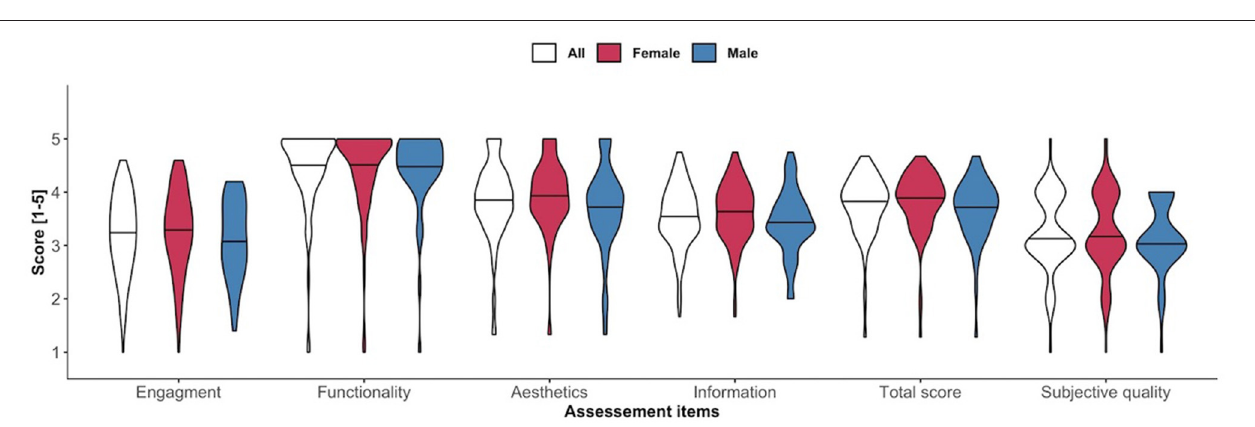
FIGURE 2 | Violin plots of uMARS subdomains, total score and subjective quality according to disease group.